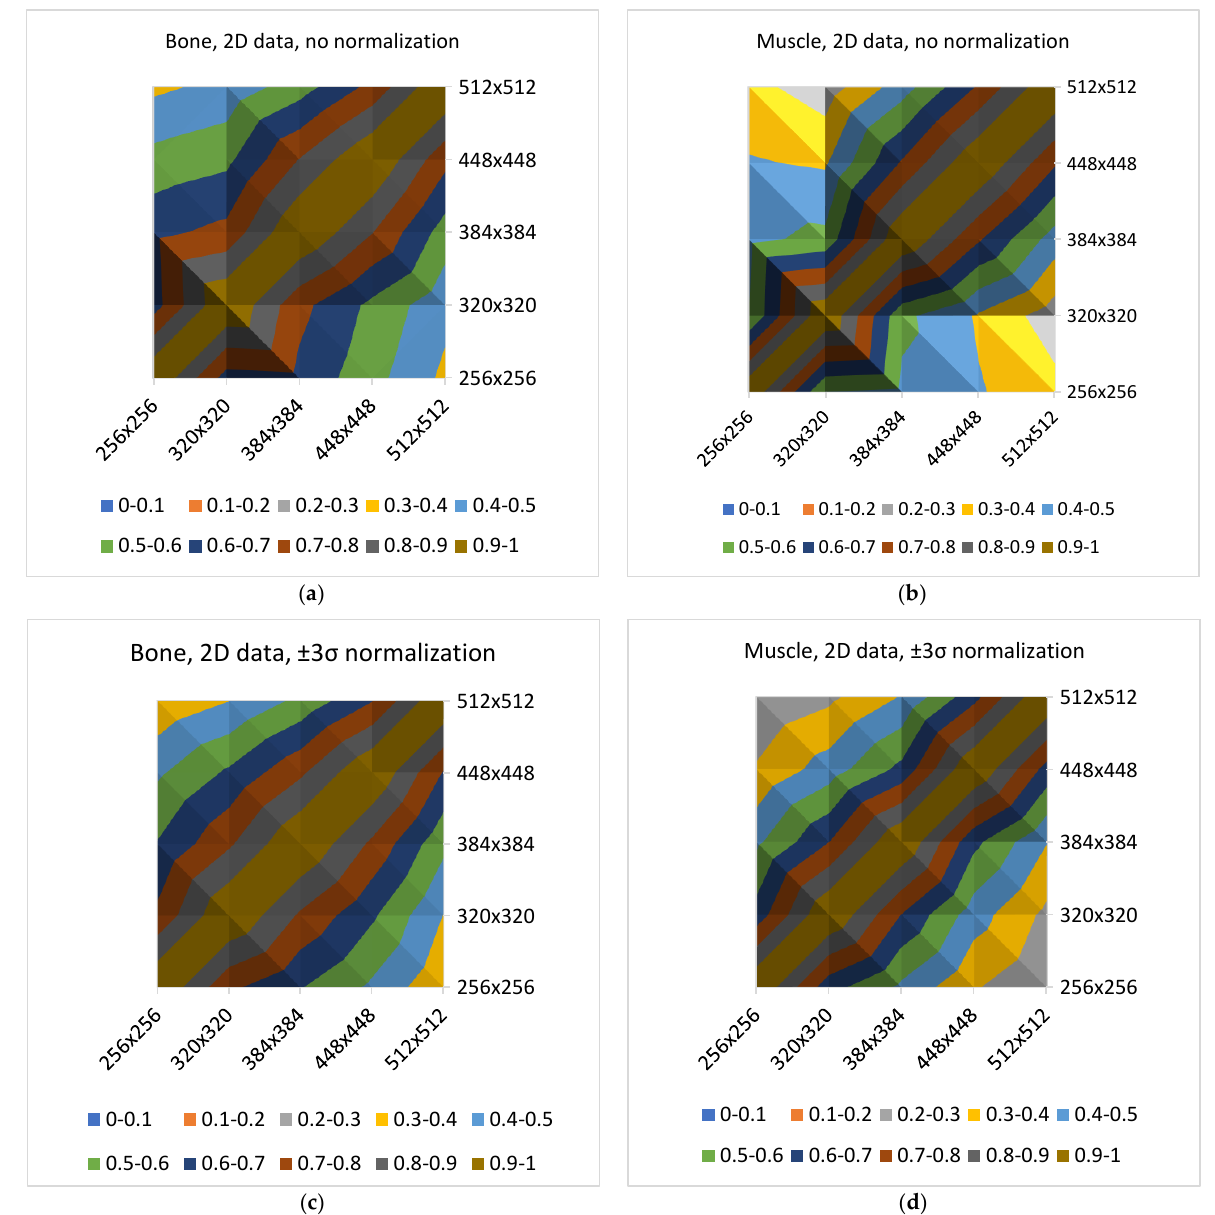
Figure 9. ( a ) Values of correlation coefficients averaged at all transitions between matrices; ( b ) mean change of correlation coefficients at all transitions between the matrices.